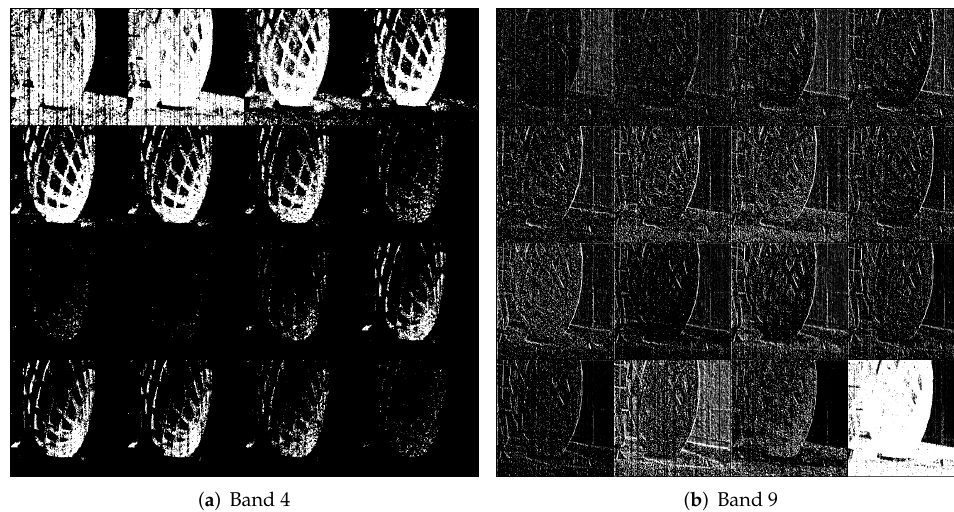
Figure 15. 16 important feature maps in the Band 4 and